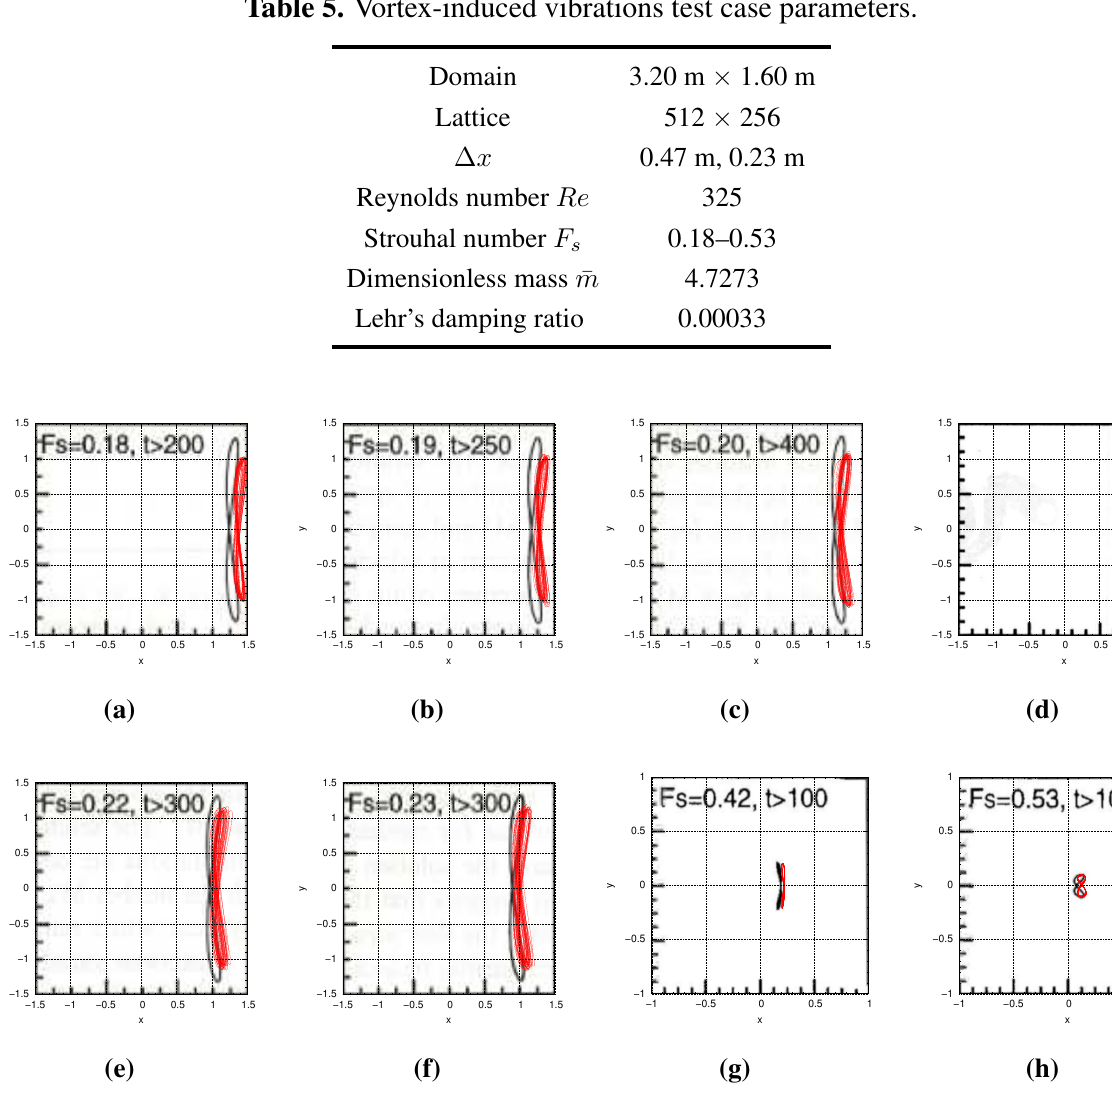
s = 0 . 19 ; s = 0 . 53 s